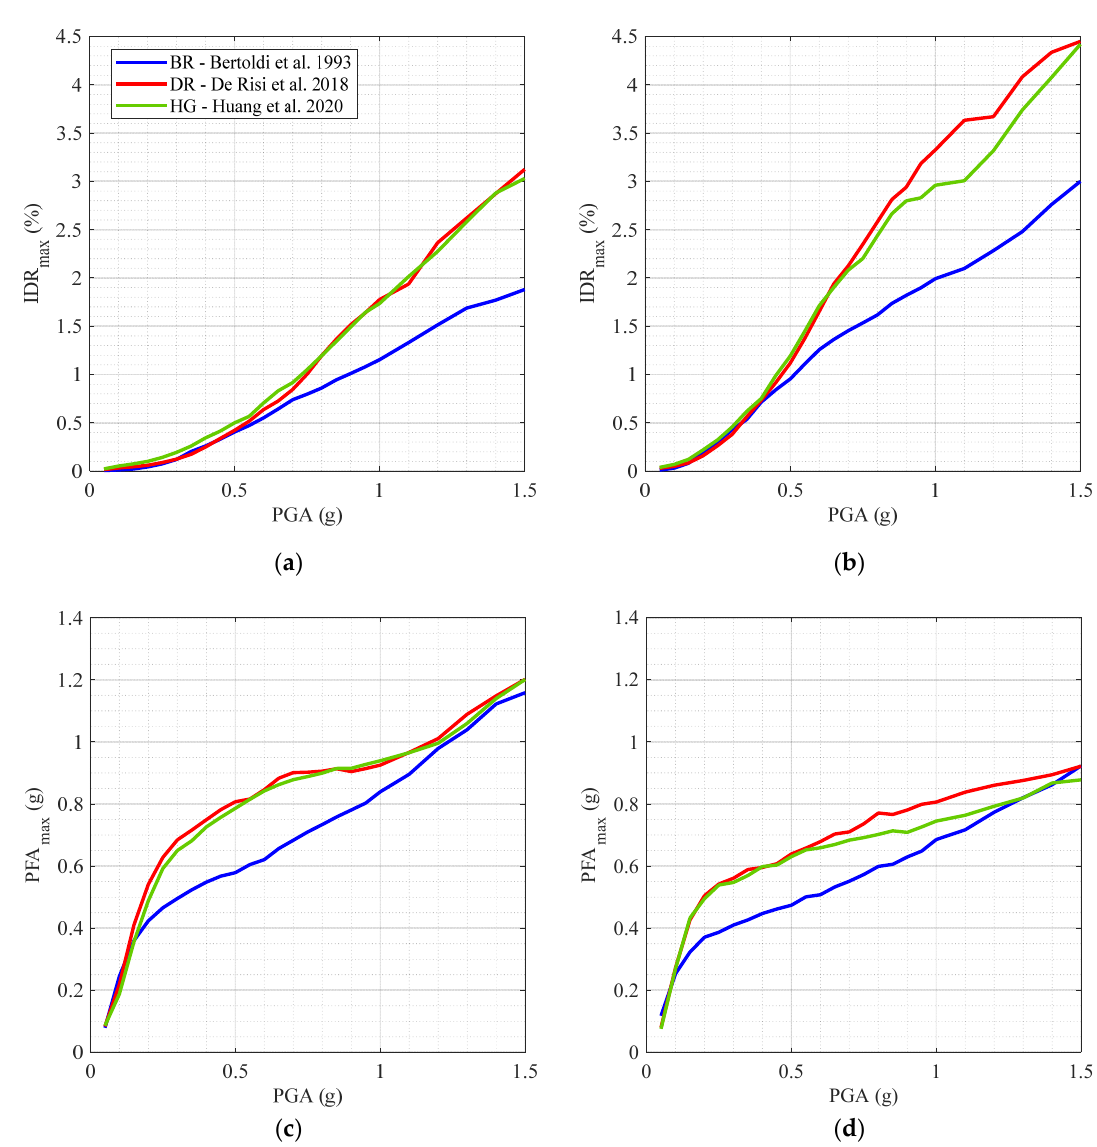
Figure 11. Maximum interstory drift ratios for ( a ) longitudinal and ( b ) transverse direction and maximum peak floor accelerations for ( c ) longitudinal and ( d ) transverse direction.